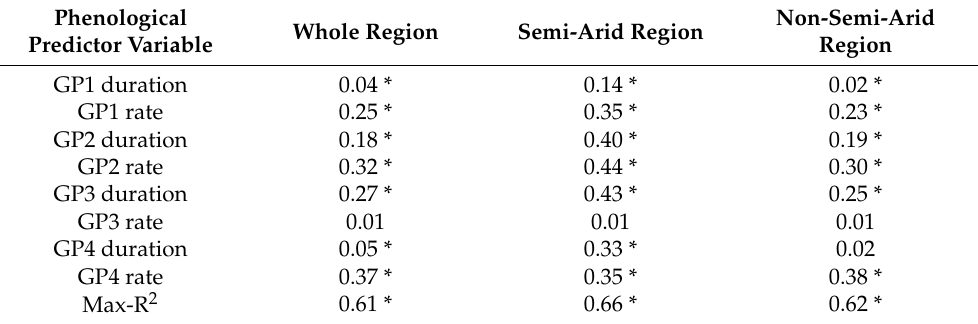
Table 1. R 2 between the duration (days), rate ( ∆ NDVI/days), and Max-R 2 and yield (kg/ha). The whole region contains all counties located in the semi-arid and non-semi-arid regions; semi-arid refers to the counties in the semi-arid region and non-semi-arid refers to the counties in the non-semi-arid region. Non-Semi-Arid Phenological Whole Region Semi-Arid Region Region Predictor Variable GP1 duration 0.04 * 0.14 *